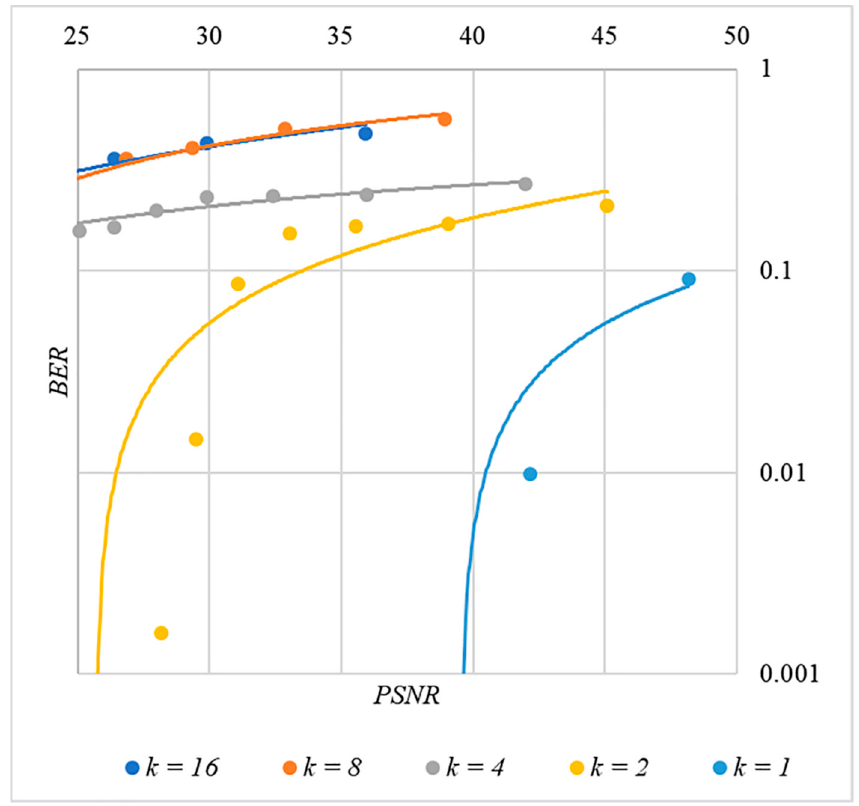
Figure 13. BER ( PSNR ) dependencies for different values k rule for generating chip codes № 1.